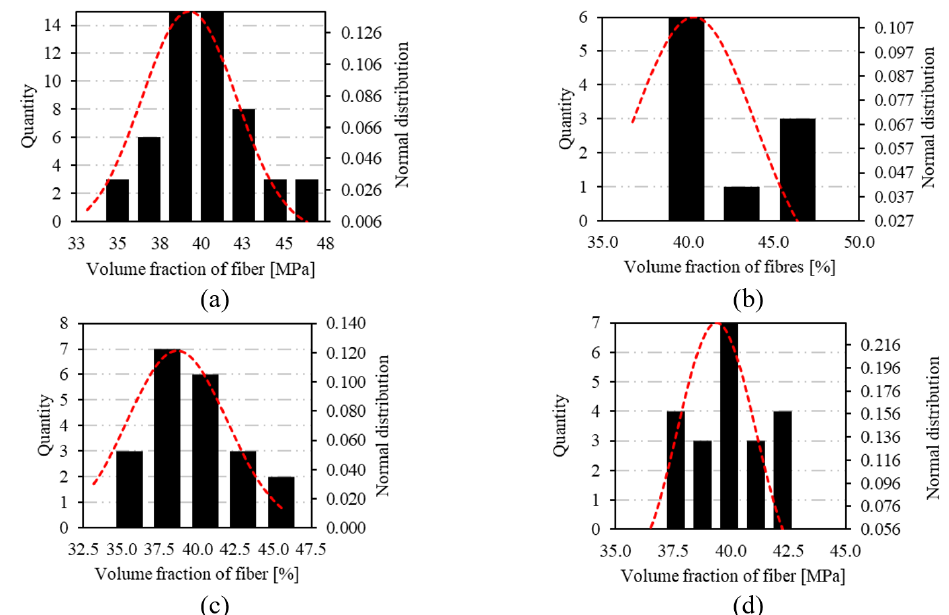
Figure 13. Histograms and normal distribution curves of volume fraction of fibre test results for: (a) all specimens; (b) group A;